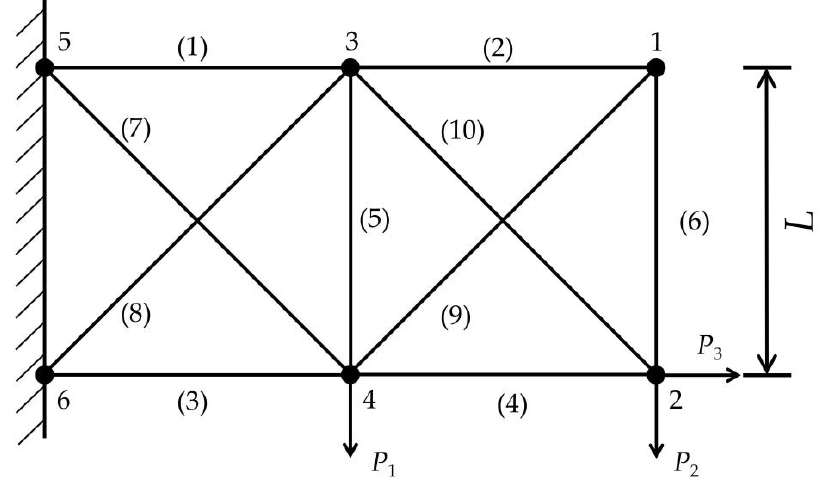
Figure 9. The 10-truss girder in Example 3. Table 5. Statistical parameters for Example 3.